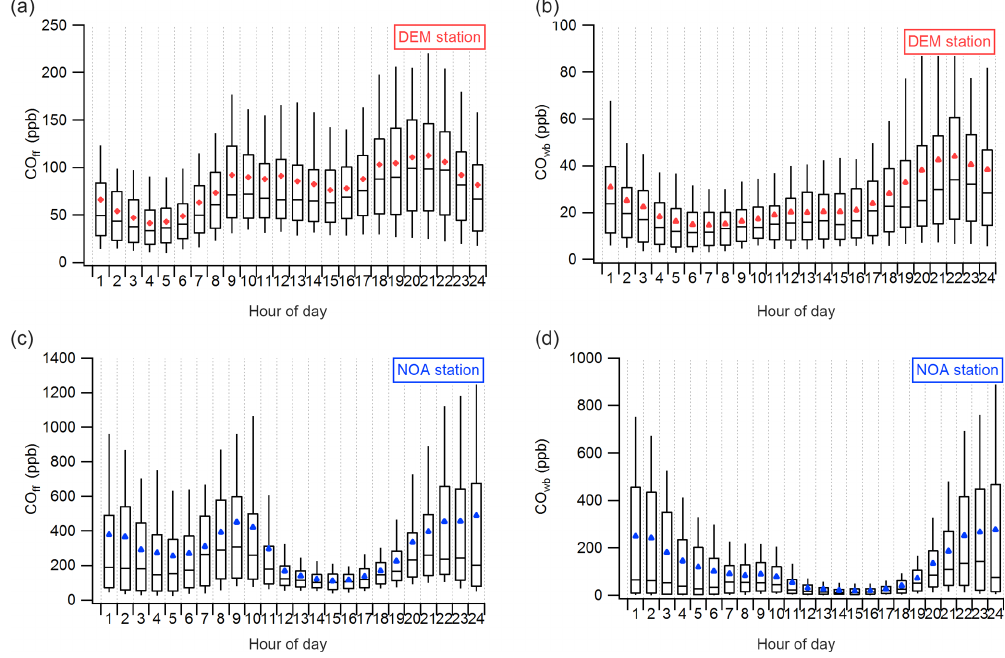
Figure 10. Diurnal variations of CO ff (a, c) and CO wb (b, d) at DEM (a, b) and NOA (c, d) stations. Data are presented as box and whisker plots, where boxes encompass values between the 25th and 75th percentiles, horizontal lines represent median values, and “whiskers” give the 80% range of the values, whereas coloured markers represent the mean values.